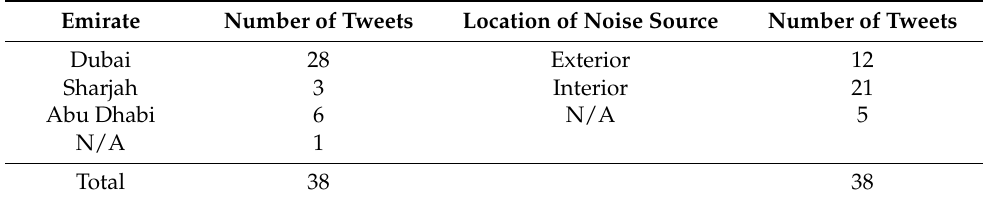
Table 3. Location of annoying noise tweets, UAE